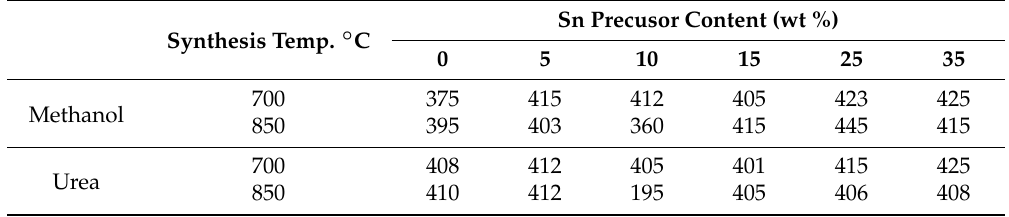
Figure 10. Electrocatalytic activity of Ni/C nanofibers containing different Sn contents and prepared at 700 °C ( A ) and 850 °C (B) toward urea oxidation (1.0 M in 1.0 KOH) at room temperature and a scan rate of 50 mV/s. Table 2. The onset potentials (mV vs. Ag/AgCl) of urea and methanol oxidation at the surface of the proposed nanofibers.